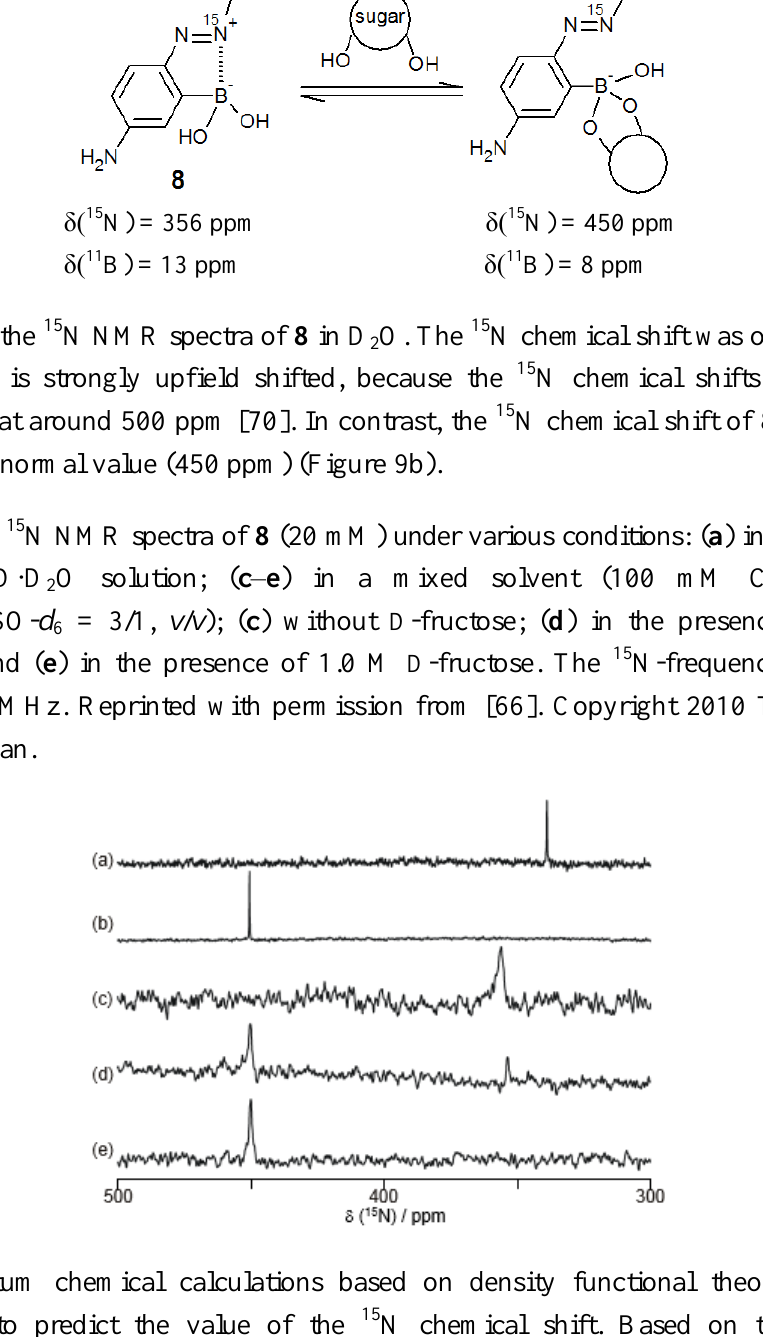
Figure 8. The equilibrium of dye 8 and sugar, and their chemical shifts in multinuclear NMR.